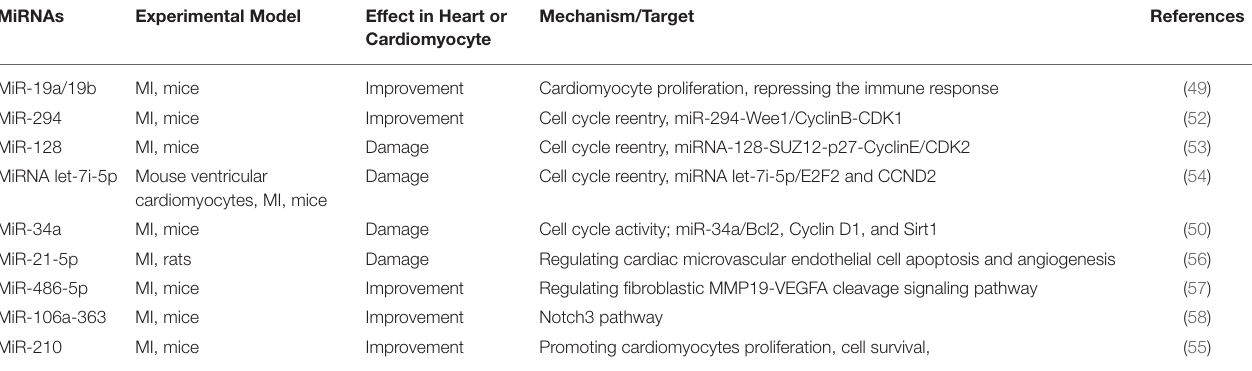
TABLE 3 | Summary of studies on miRNA regulating MI by proliferation in the past 5 years.